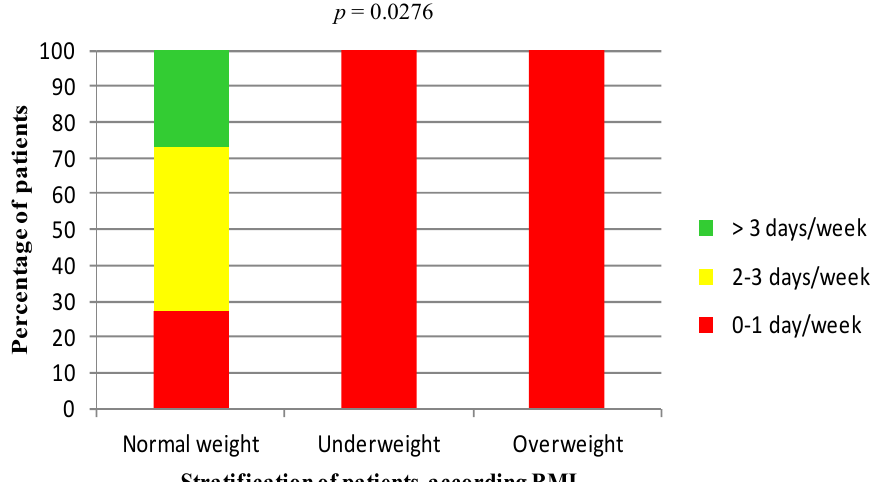
Figure 2. Relationship between frequency of physical activity and BMI. Patients are stratified according to BMI values into three group: normal weight (18.5–24.9 kg/m 2 ), underweight (BMI < 18.5 kg/m 2 ), and overweight (BMI > 24.9 kg/m 2 ). Chi-squared test.